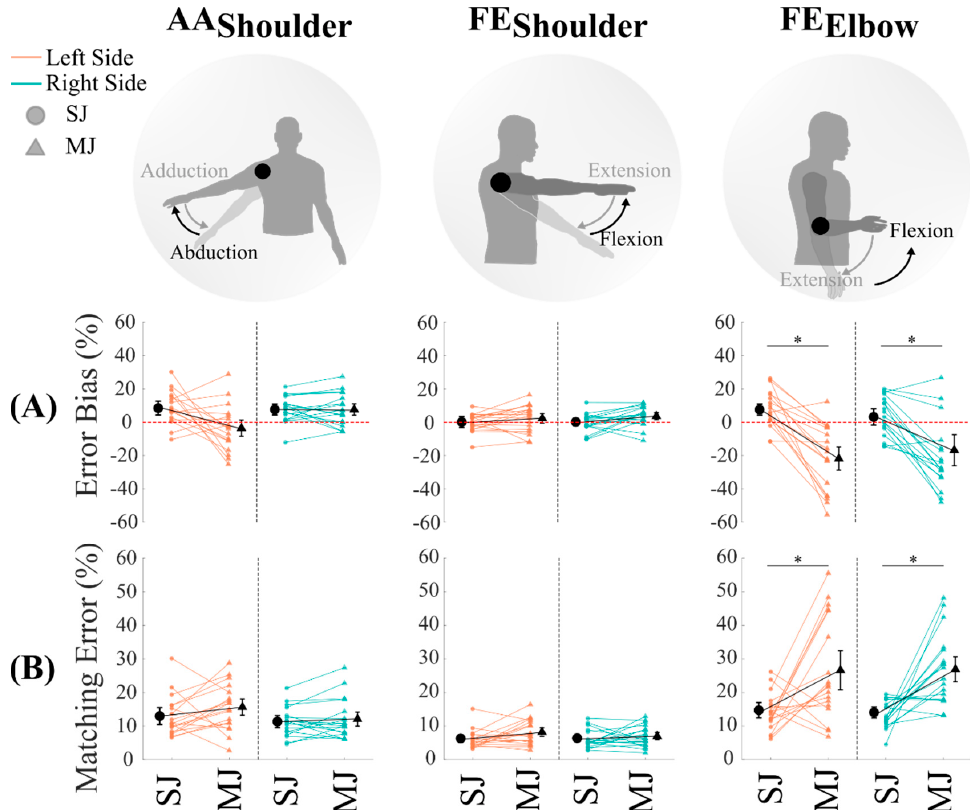
Figure 2. Outcome measures relative to the Error Bias and the Matching Error. In each graph, the orange color represents the left body side, while the green color represents the right one. The single-joint condition (SJ, which could be: AA Shoulder or FE Shoulder or FE Elbow ) is represented by a round marker, while a triangular marker represents the multi-joint condition (MJ). Black markers denote the averaged value between the subjects for each condition; the colored ones represent the mean value for each participant across the trials. Each column represents one DoF (AA Shoulder , FE Shoulder , and FE Elbow ). ( A ) Error bias. ( B ) Matching error. * represents the significant differences between the two conditions (SJ and MJ). Table 1. Mean values and standard errors (%) for the Error Bias and Matching Error.